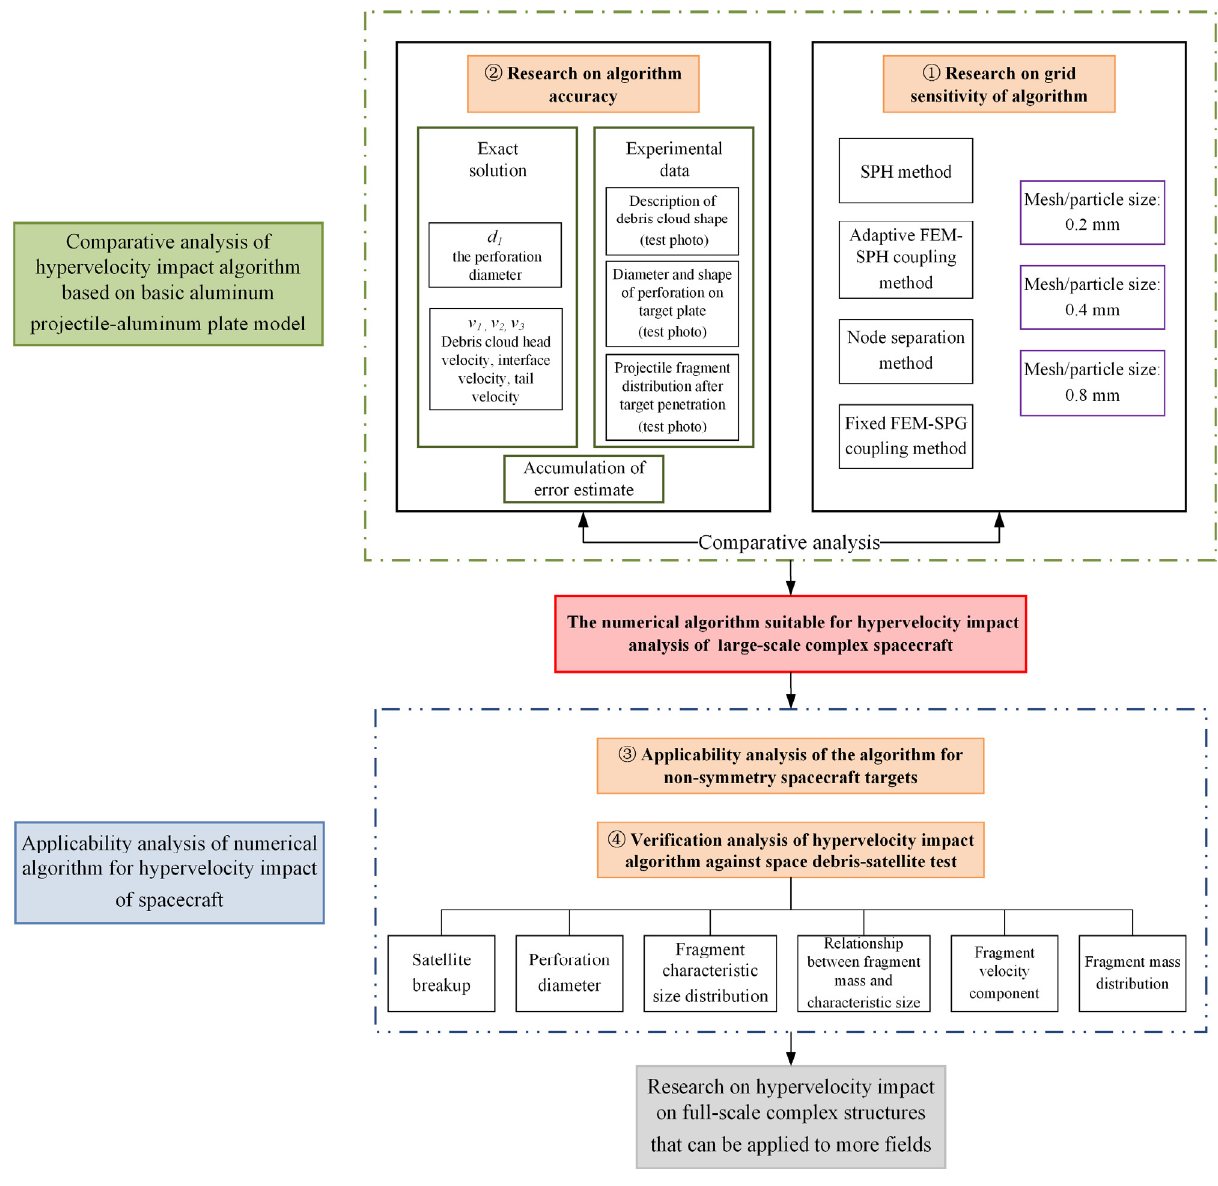
Figure 2. Logic diagram of the main research